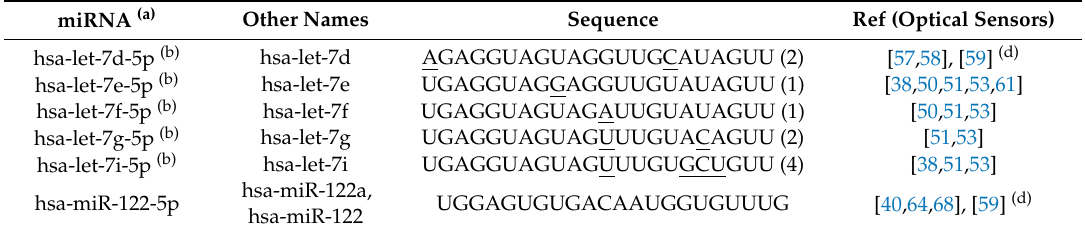
Table 3. Summary of miRNAs only employed in specificity